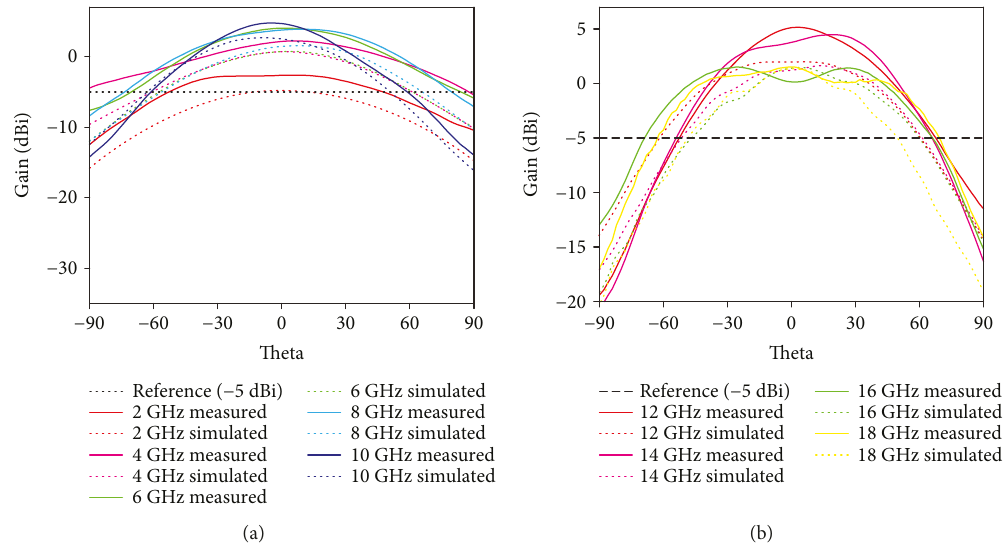
Figure 10: Comparison of measured (solid line) and simulated (dotted line) radiation pattern from (a) 2 – 10 GHz and (b) 11 –